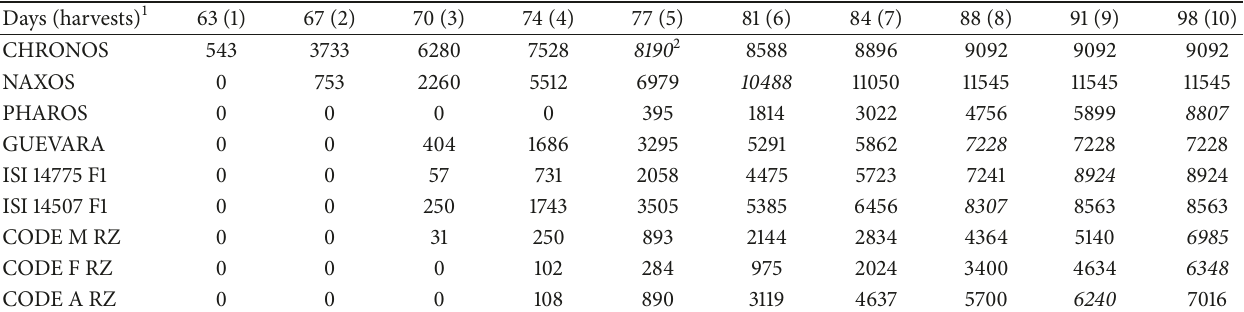
Table 2: Cumulative production (kg ha −1 ) of different cultivars of broccoli.